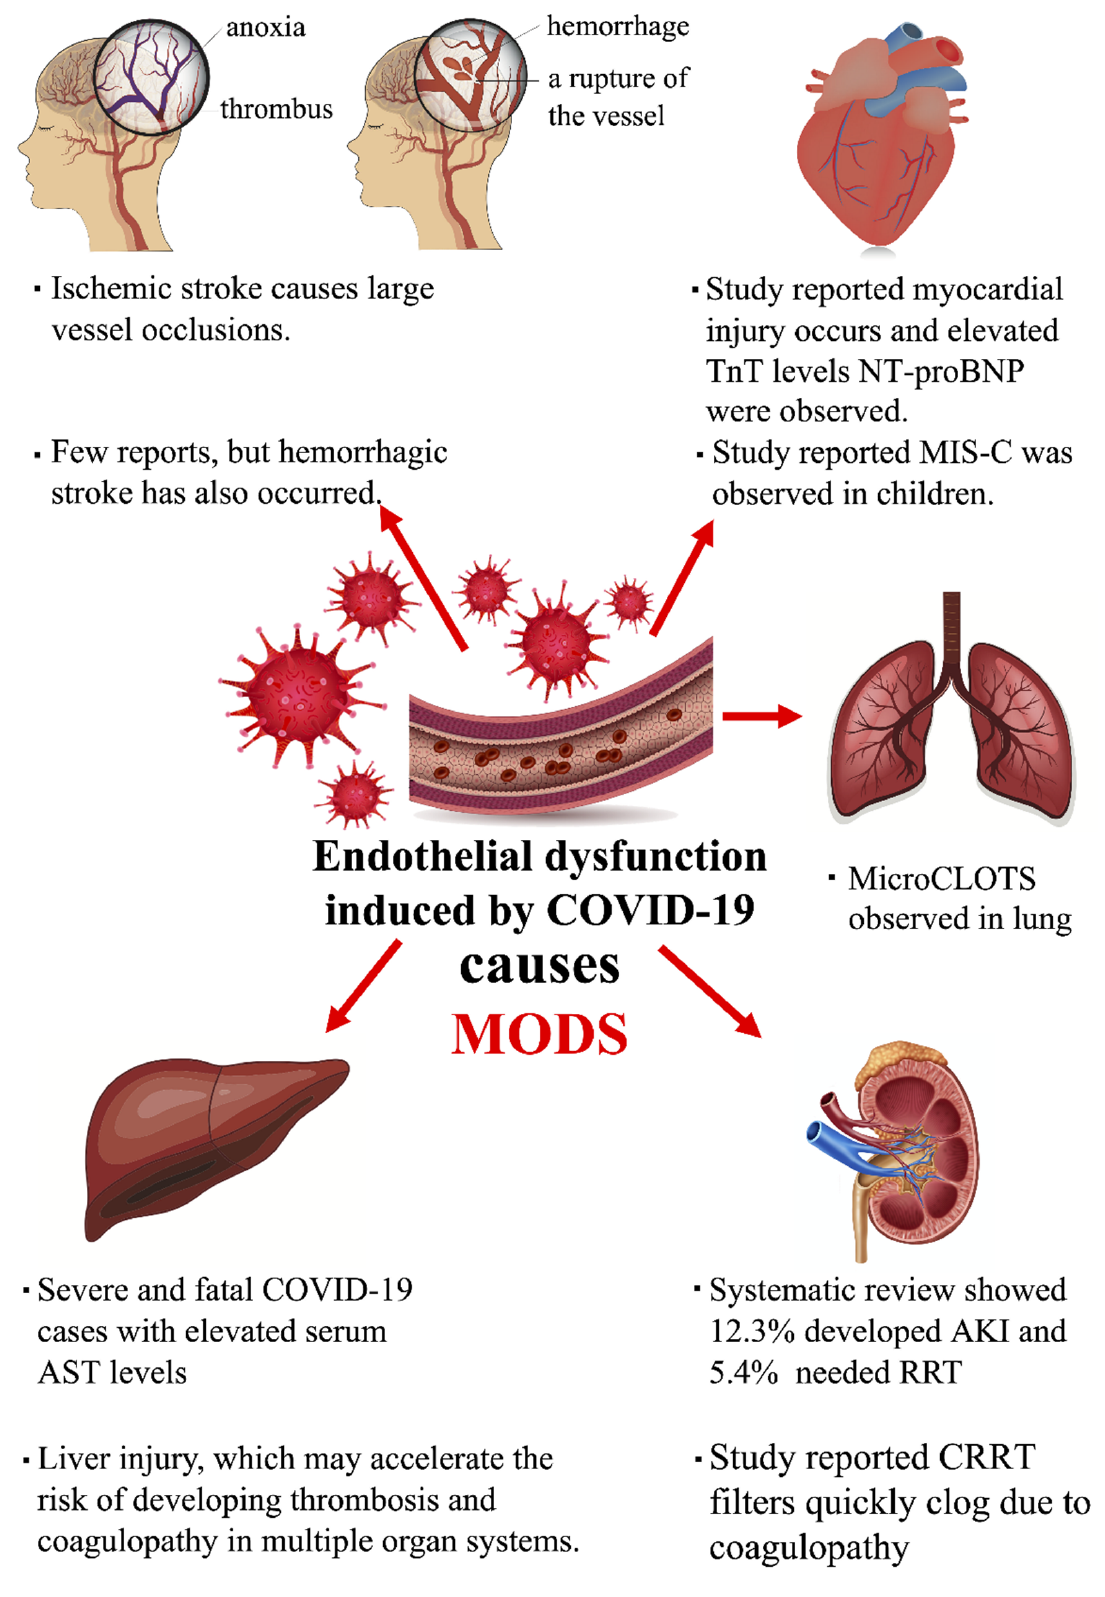
Figure 1. Endothelial dysfunction induced by COVID-19 develops into MODS.